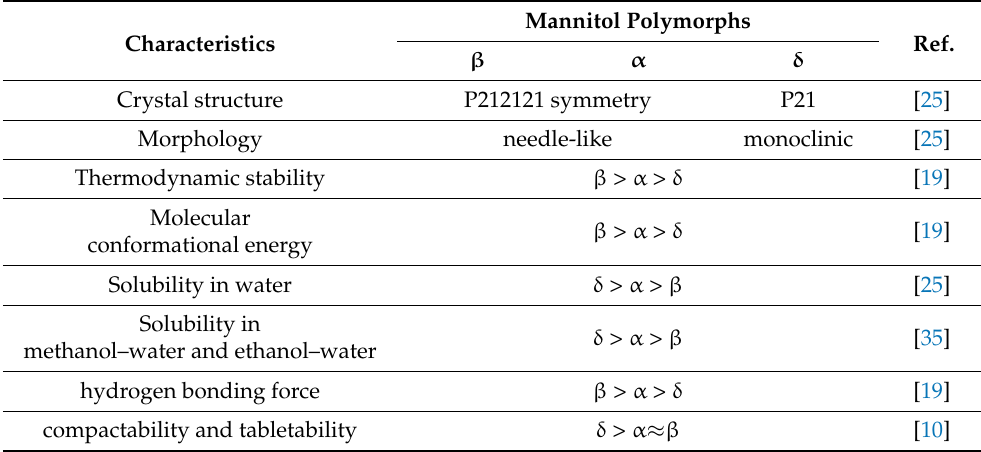
Table 2. Physicochemical properties of different D -mannitol polymorphs.